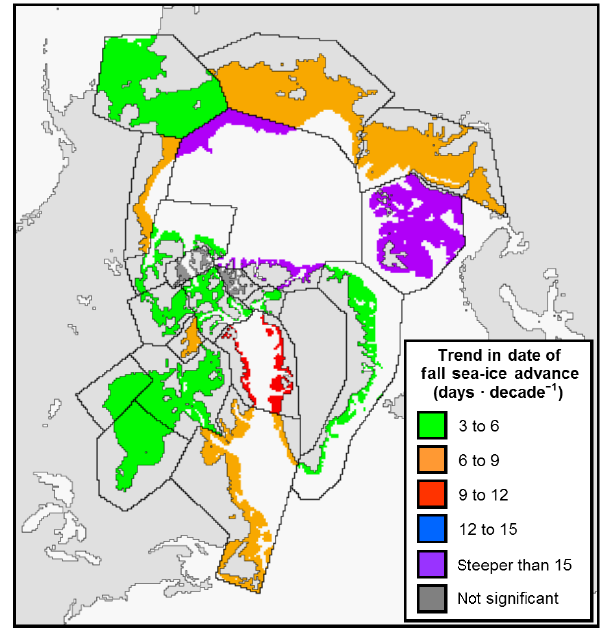
Figure 11. Trend map of the date of fall sea-ice advance for the shallow parts of each PBSG region. Trends are also given in Table 4.